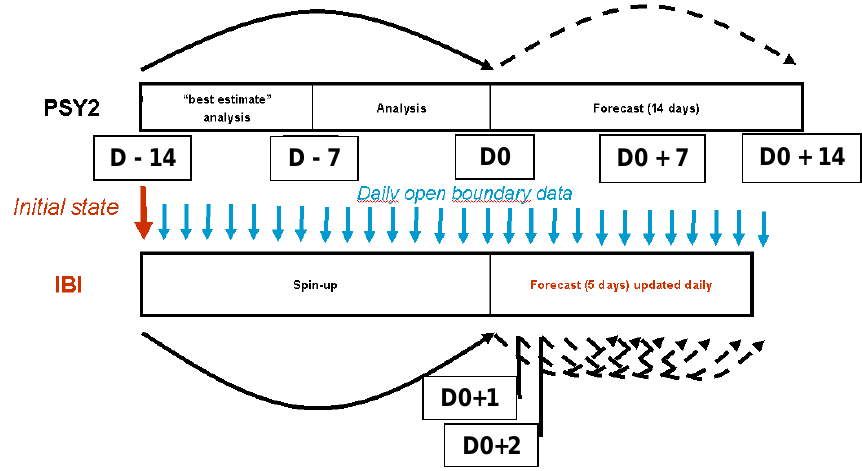
Figure 6 : Operational protocol scheme for V2 system. Fig. 6. Operational protocol scheme for V2